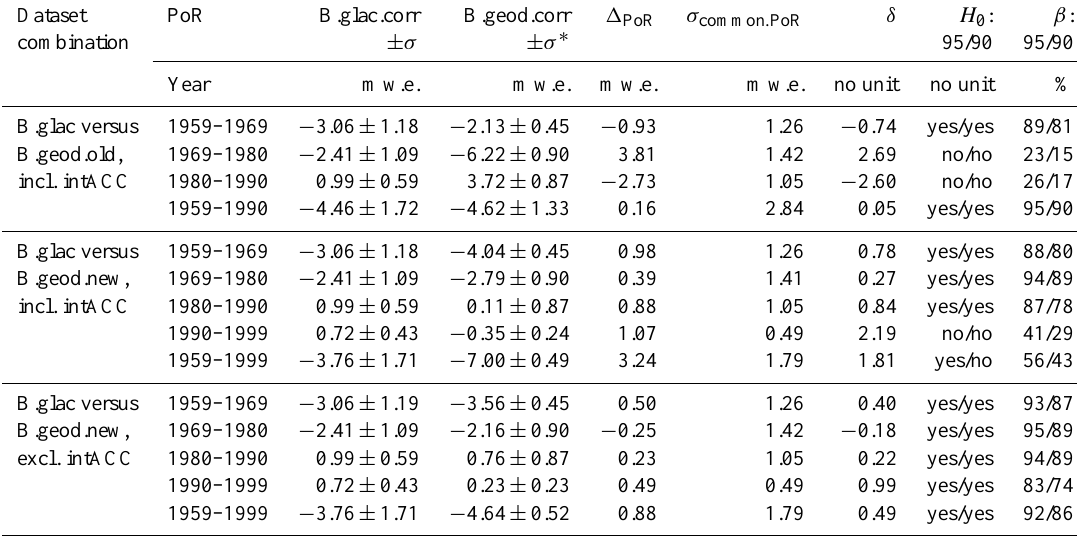
Table 2. Summary statistics for the comparison of glaciological and geodetic balances of Storglaci¨aren, Sweden. For different dataset combinations, the table shows analysed periods of record (PoR) with bias-corrected balances (B.corr) and related random uncertainties ( ± σ) for both the glaciological (glac) and the geodetic (geod) methods, together with cumulated discrepancies ( 1 PoR ) , common variance ( σ common . PoR ) , and reduced discrepancy ( δ) calculated according to Eqs. (19)–(21). The acceptance (rejection) of the hypothesis ( H 0 : the two balances are equal) is evaluated on the 95% and 90% confidence level (i.e. a type-I risk), which corresponds to reduced discrepancies inside (outside) the ± 1.96 and ± 1.64 range, respectively. For the same confidence levels, the type-II risk β (cf. Eq. 22) of not detecting an erroneous series is also